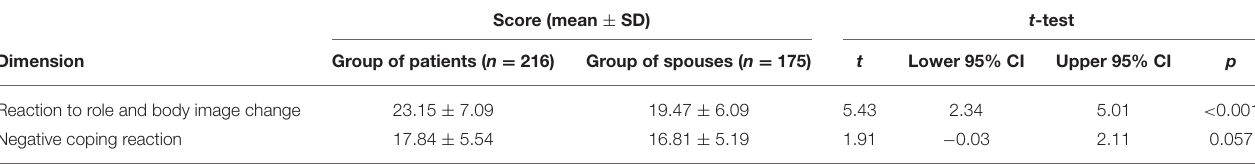
TABLE 3 | Gender difference in two dimensions of psychological